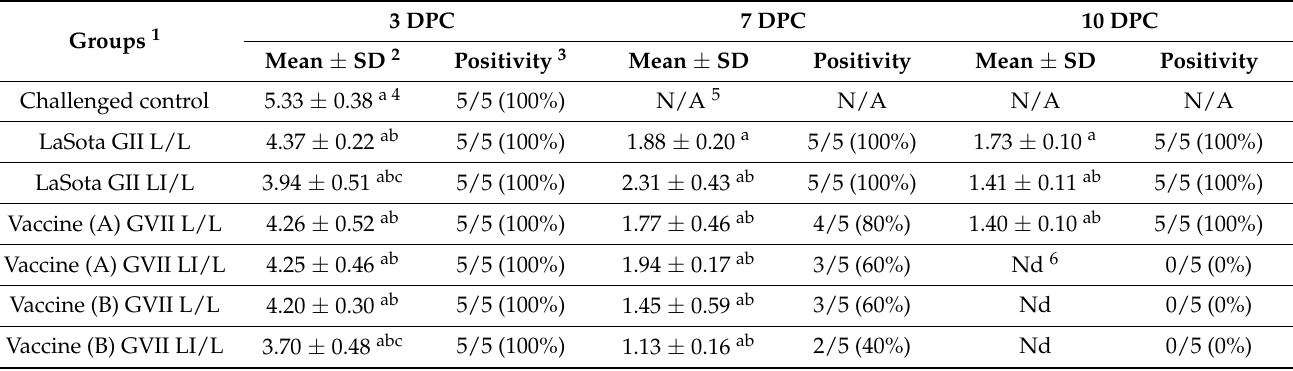
1 Abbreviations: GII: genotype II-based vaccine, GVII: genotype VII.1.1.-based vaccine, L/L: live vaccine at 7 and 21 days, LI/L: live and inactivated at 7 days, then live vaccine at 21 days. 2 The mean shedding titer ± SD is expressed as EID 50 /mL using RT-qPCR. 3 Positivity %: percentage of active virus shedder birds out of the tested samples. 4 N/A: not applicable. 5 Virus titers in the same column followed by different small letters are statistically different. ( p < 0.05). 6 Nd: not